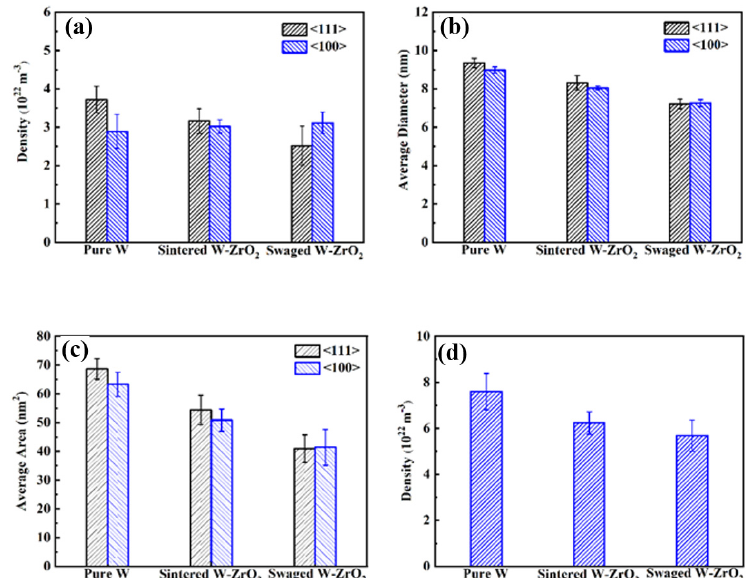
Figure 7. Damage statistics for the three irradiation samples after 1.5 × 10 15 Au + /cm 2 irradiation: ( a ) dislocation density of <111> and <001> type loops, ( b ) average diameter of <111> and <001> type loops, ( c ) average area of <111> and <001> type loops, ( d ) total dislocation loops density.